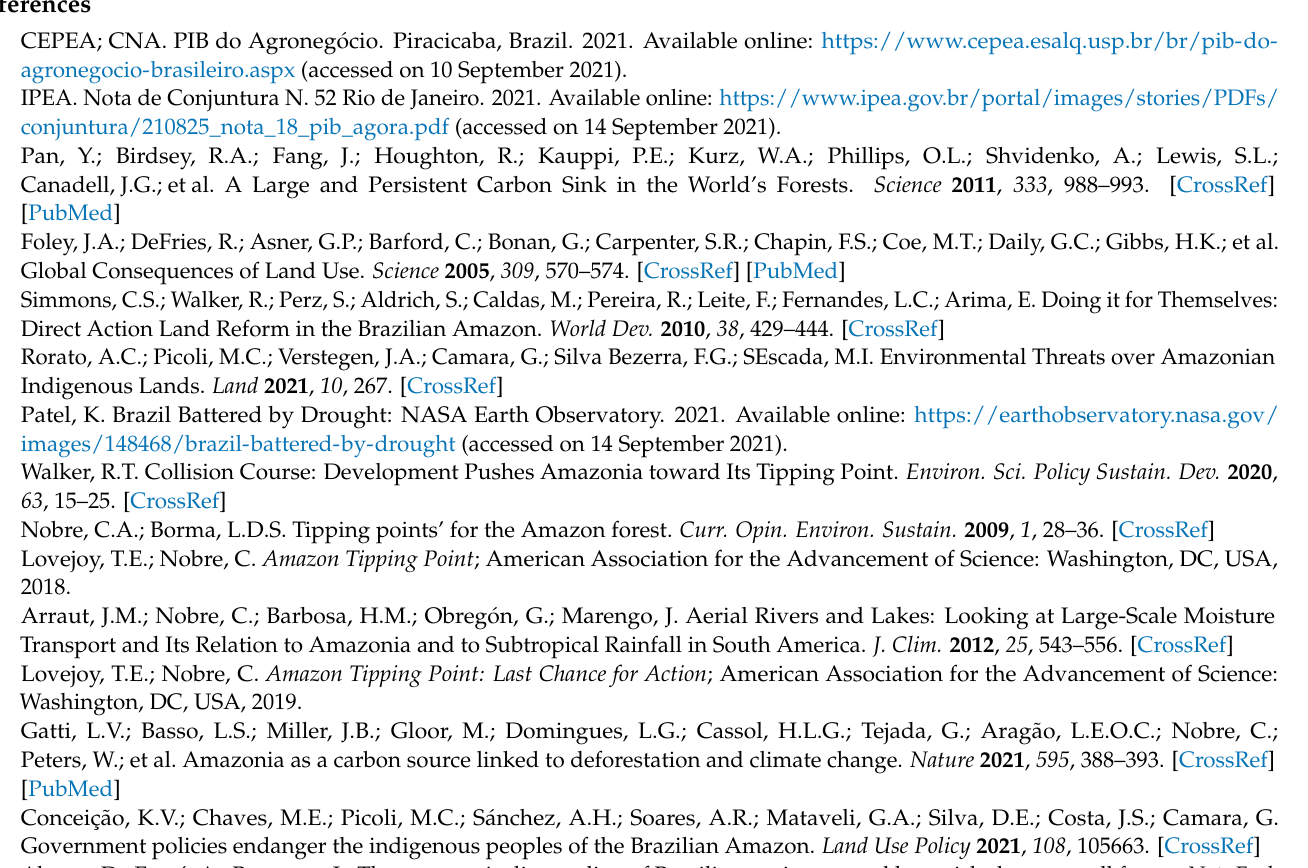
Table S8: Cross-tabulation of predicted vs. actual deforestation on a pixel-by-pixel basis, Table S9: Crosstabulation of predicted vs. actual deforestation Hagen’s two-way fuzzy similarity index, Table S10: Indigenous and conservation areas within 5 km from hotspots of